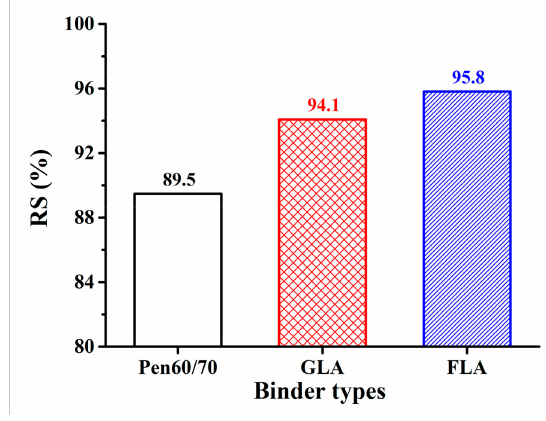
Figure 11. Marshall test results: ( a ) Marshall stability and ( b ) flow value.